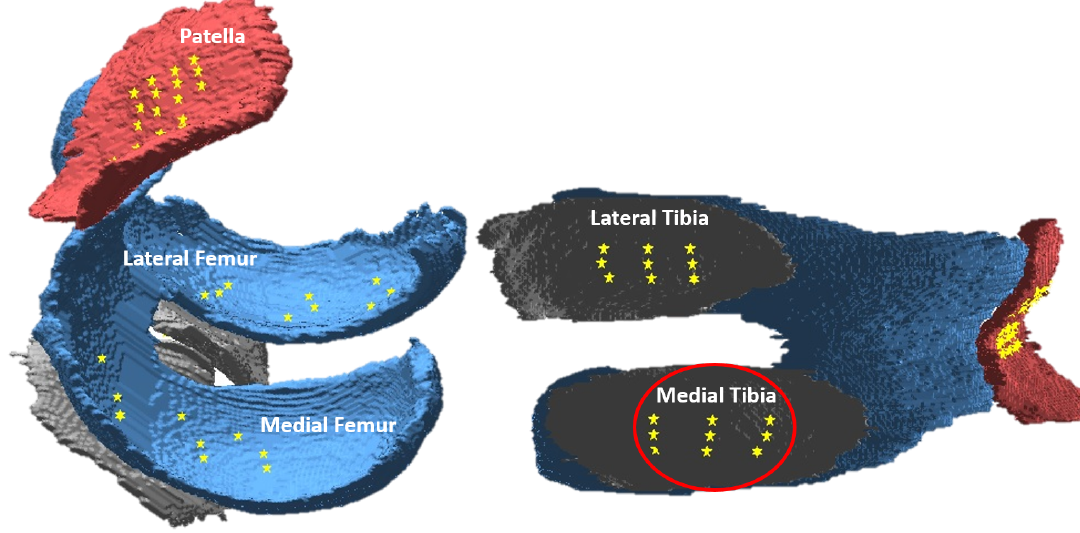
Figure 1. Cartilage damage index (CDI) locations (yellow points) on 3D cartilage layer [16]. This study focused on the CDI locations on medial tibia compartment (red